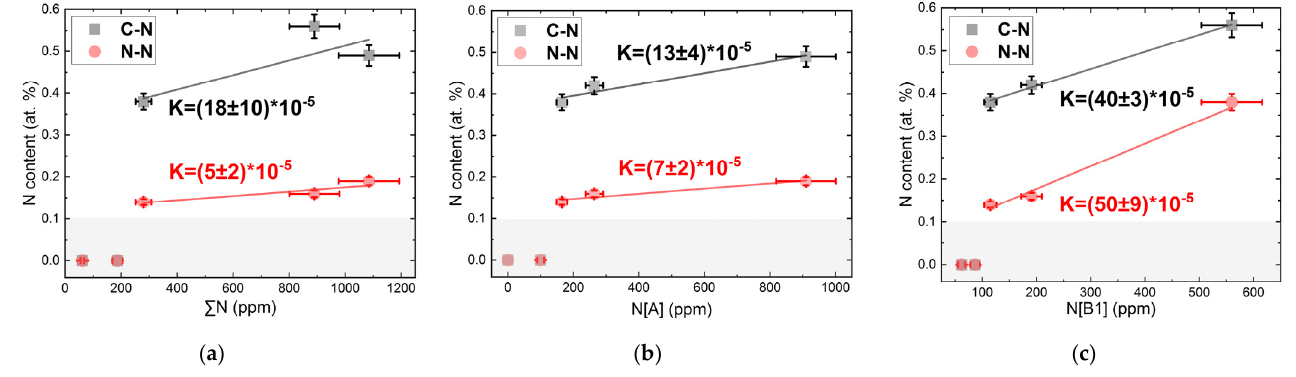
Figure 4. Correlation plots for IaAB and IaB diamonds: ( a ) XPS-acquired N–N and C–N intensities versus Σ N ; ( b ) XPS-acquired N–N and C–N intensities versus [A]; ( c ) XPS-acquired N–N and C–N intensities versus [B1]. The bottom grey highlighted band denotes the device detection limit of 0.1 at. %.